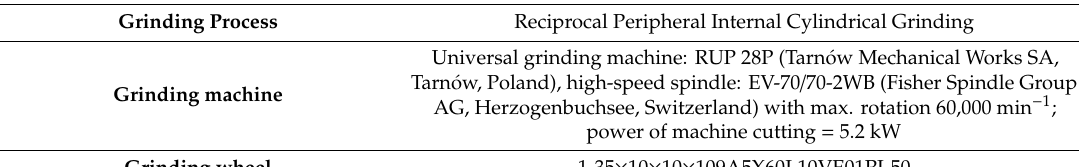
Axial table feed speed while dressing: v fd = 10 mm · s − 1